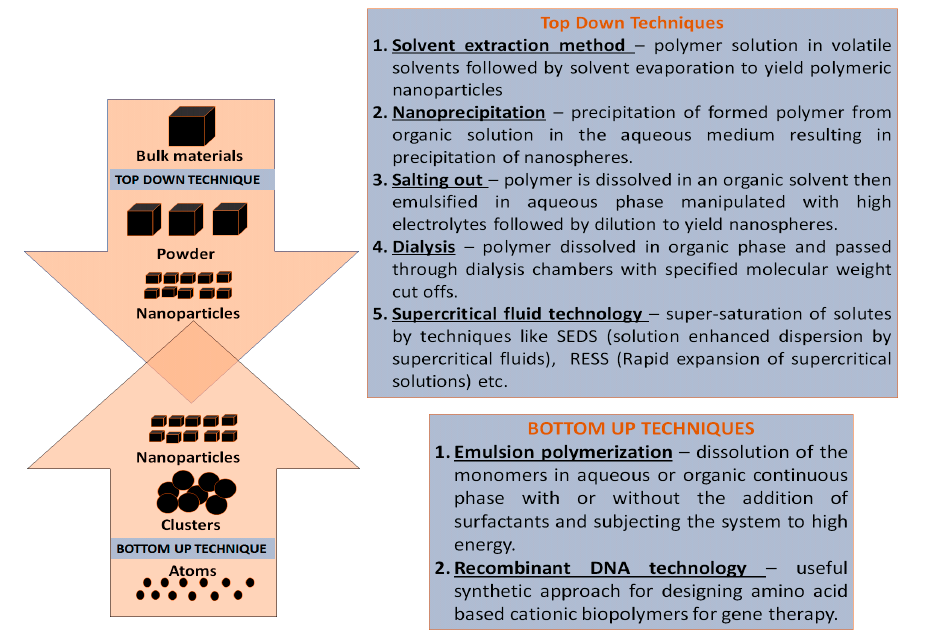
Figure 2. Summary of top-down and bottom-up techniques for generating polymeric nanoparticles.